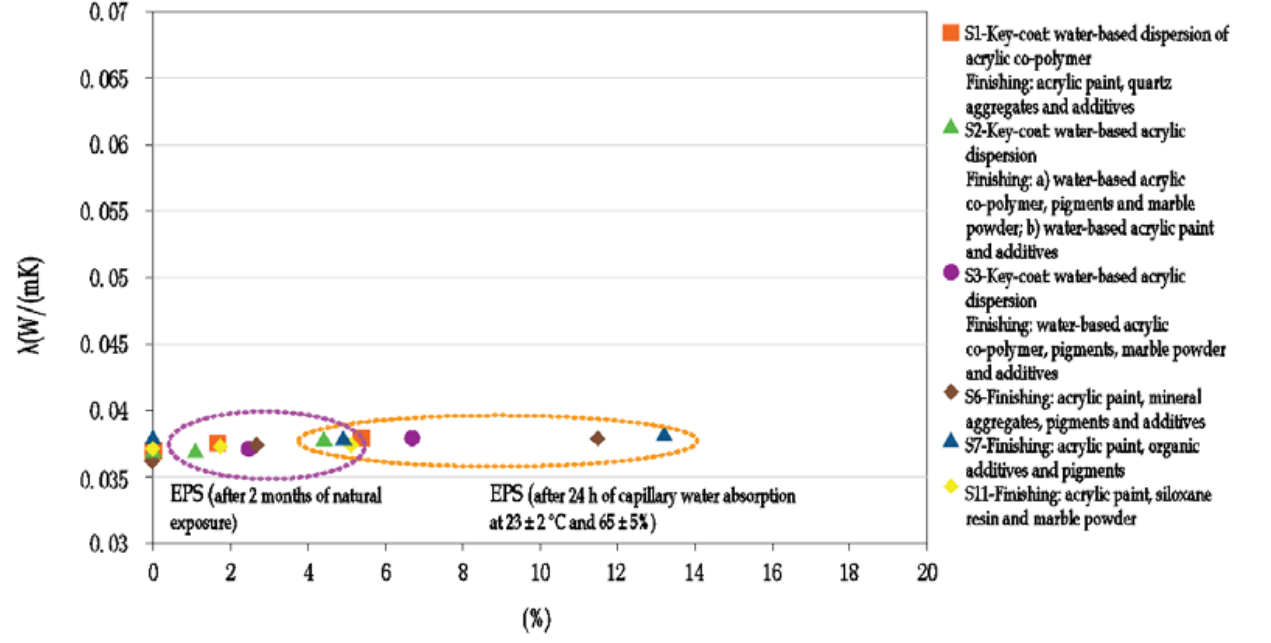
Figure 5. Thermal conductivity of the thermal insulation’s material as a function of moisture content (author’s archives based on [20]).